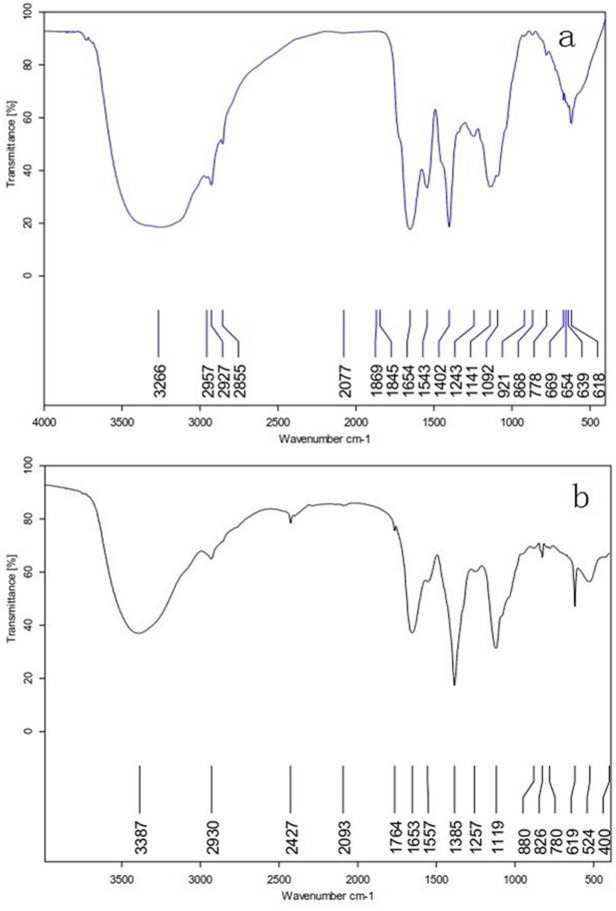
Infrared spectra of MLP-1 (a) and MLP-2 (b).